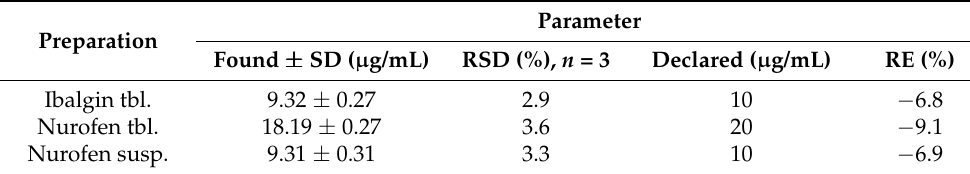
Table 4. Assay results for the determination of ibuprofen in its commercial drugs.